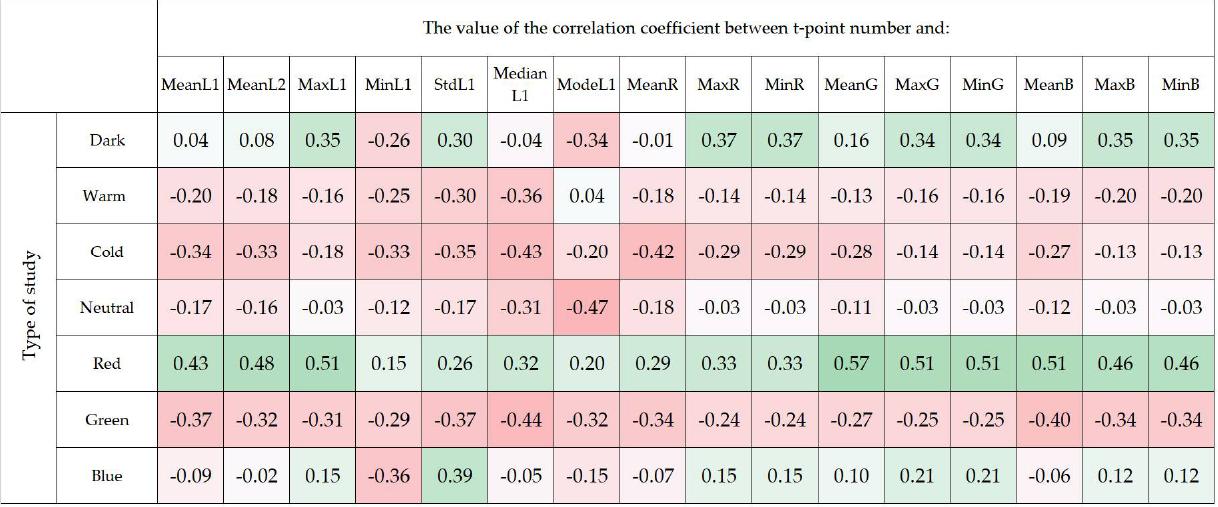
Figure 19. The value of the correlation coefficient between t-point number and the other F-point features.